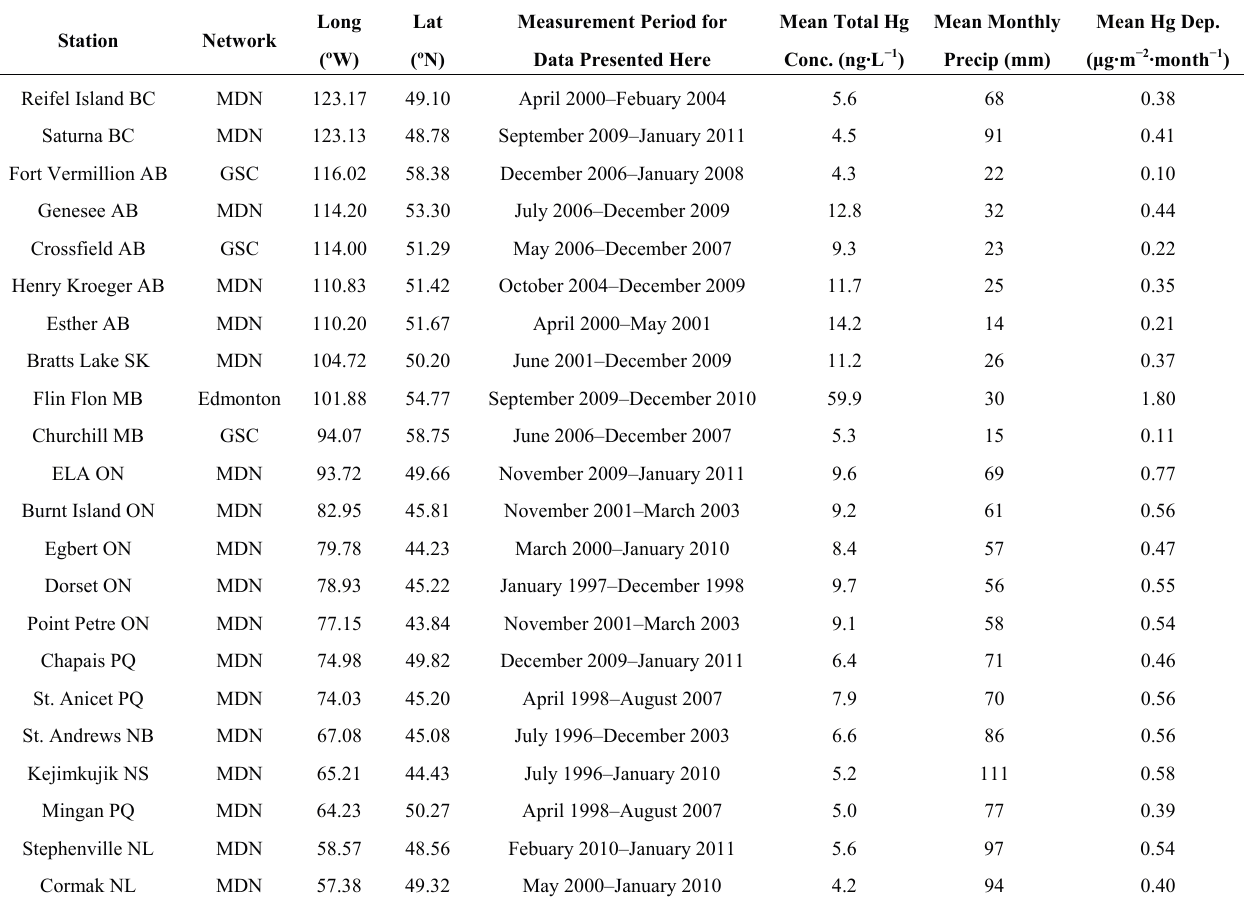
Table 3. Stations measuring Hg in precipitation in Canada and mean monthly concentration (volume-weighted means), precipitation, and deposition over the entire measurement period. MDN = Mercury Deposition Network; GSC = Geological Survey of